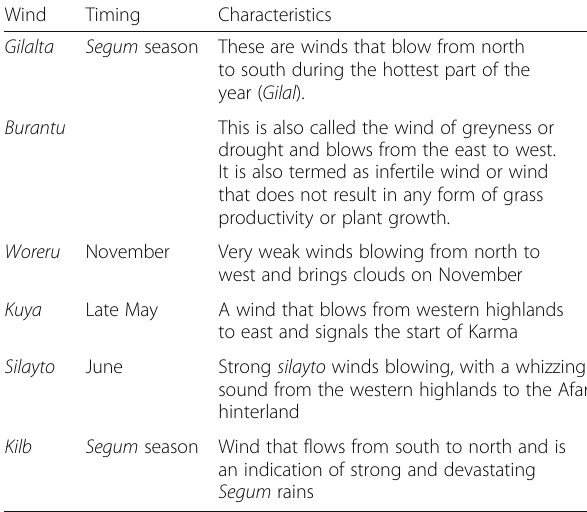
Table 2 Winds and their characteristics as described by the Afar